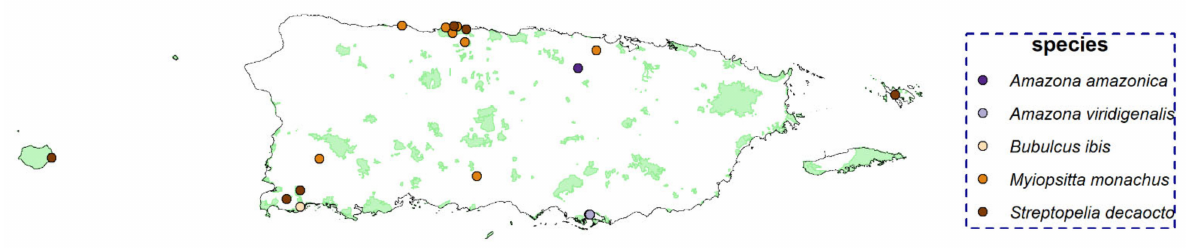
Figure A23. Map of sites where the species with low raw detections were found (<10 sites detected). The light-green polygons represent protected